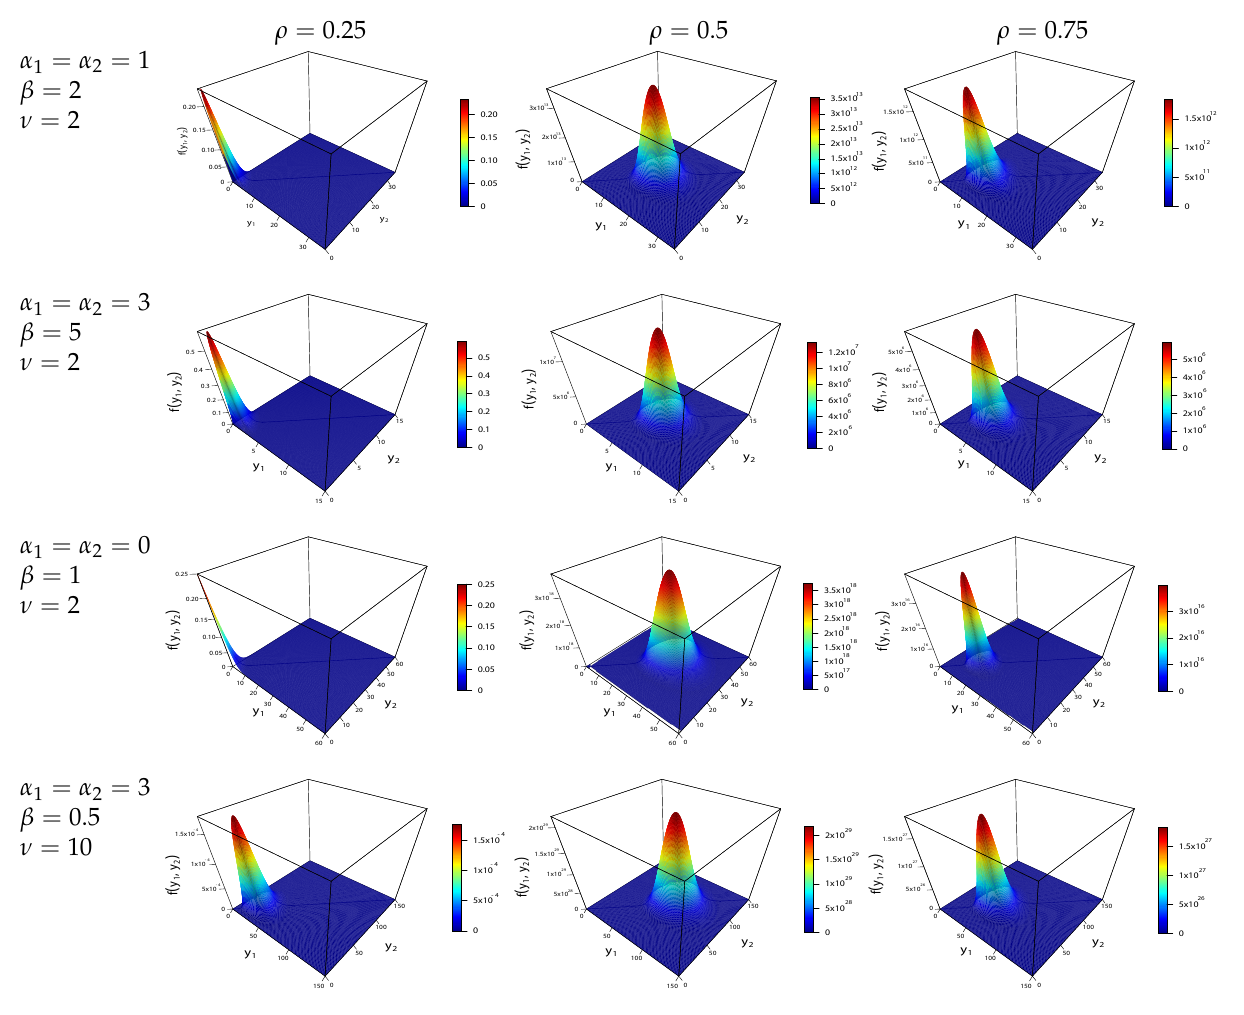
Figure 1. Bivariate pdf of Equation (6) for some parameter